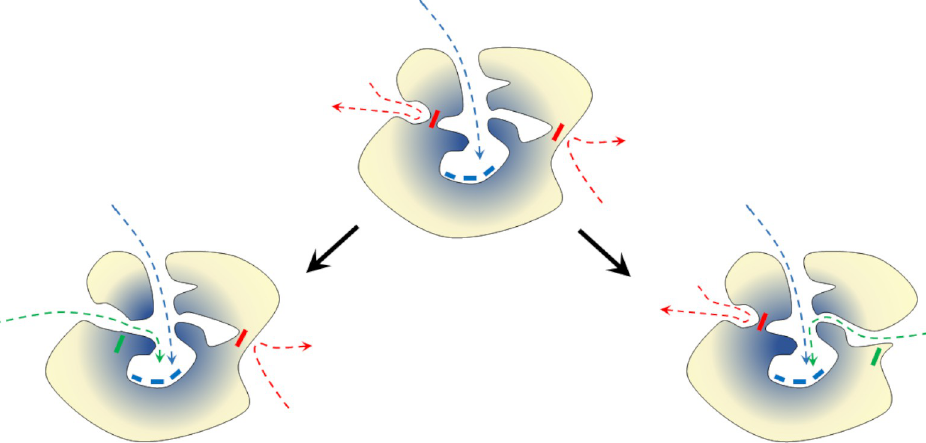
Fig 6. Schematic representation of the ‘perforation’ model of protein tunnel evolution. The ancestor protein (middle) and two modification pathways leading to a new enzyme by merging internal cavities (left) or by surface perforation (right). Yellow–variable residues; blue–conserved residues. Boxes represent residues: blue–conserved active site residues, red–potentially mutable (variable) residue, and green–mutated residue. Arrows represent pathways leading to the active site: blue–actual pathway, red–potential novel pathway, and green–novel open pathway.